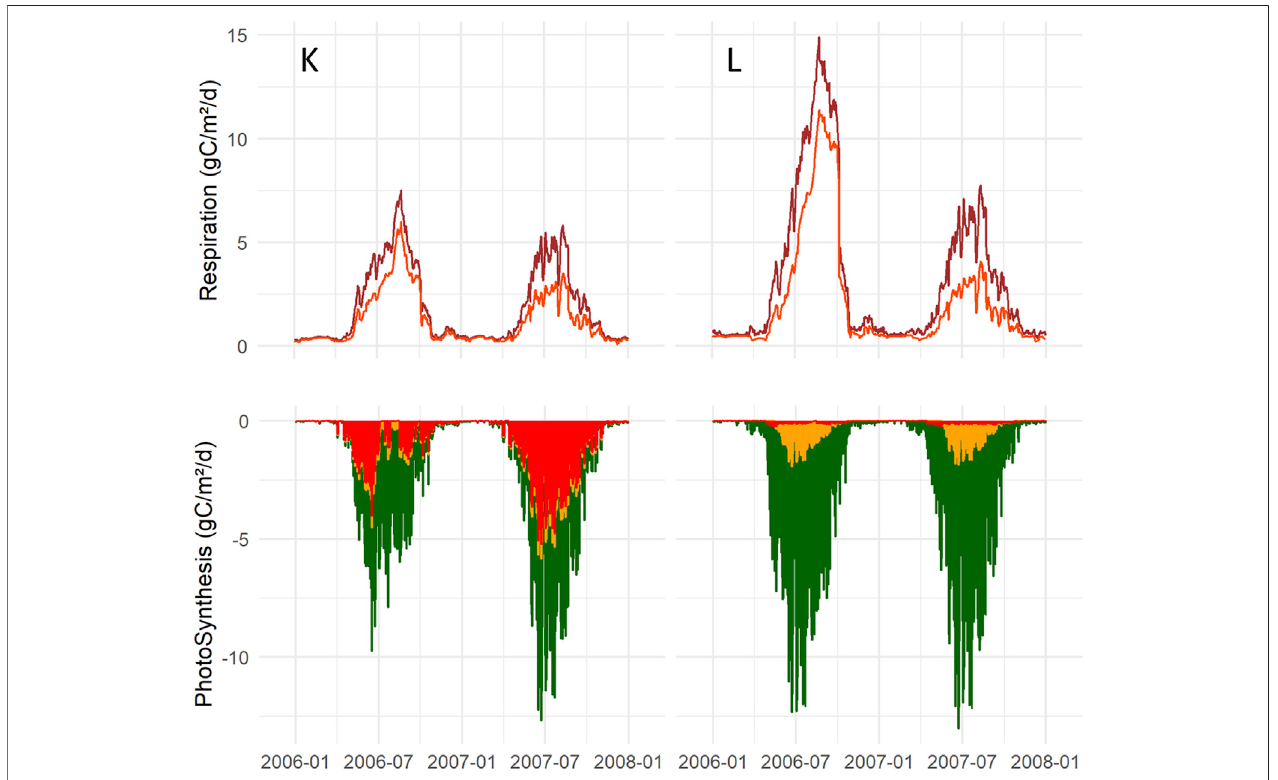
FIGURE11| Toppanelshowstotalecosystemrespiration (Reco)brownline,andheterotrophicrespiration delineated bytheredlineatK (left) andL (right) during the dry (2006) and normal year (2007). Bottom panel, stacked diagram of GPP including three vegetation layers, Vegetation1 (cid:1) dark green, Vegetation2 (cid:1) yellow and Vegetation3 (cid:1)